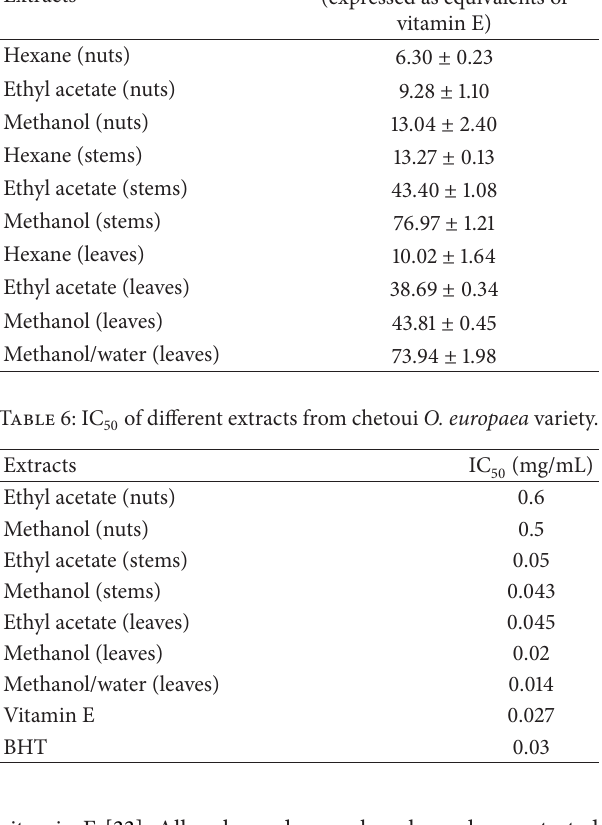
Table5:Totalantioxidantcapacityofdifferentextractsfromchetoui O. europaea variety.